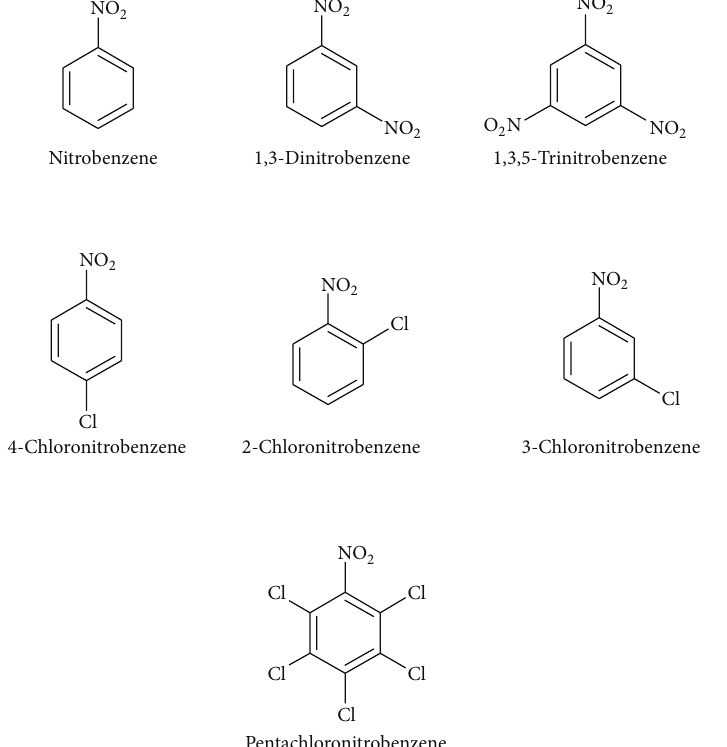
Figure 1: Structure of nitrobenzene and its